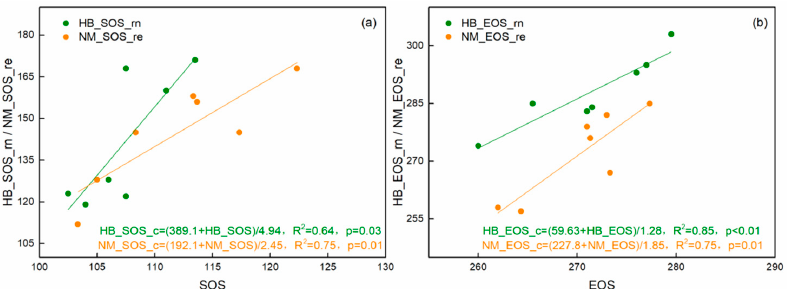
Figure 6. The linearly calibrated satellite-based phenology estimations from the actual phenological observations in HB and NM. ( a ) and ( b ) are the day of the start and end of growing season (SOS and EOS) calibration, respectively.